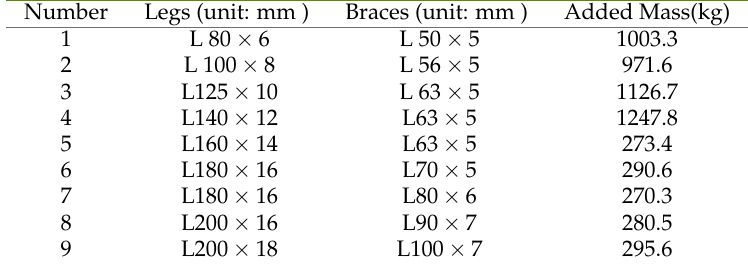
Table 1. Positive feeder lift and drag coefficient